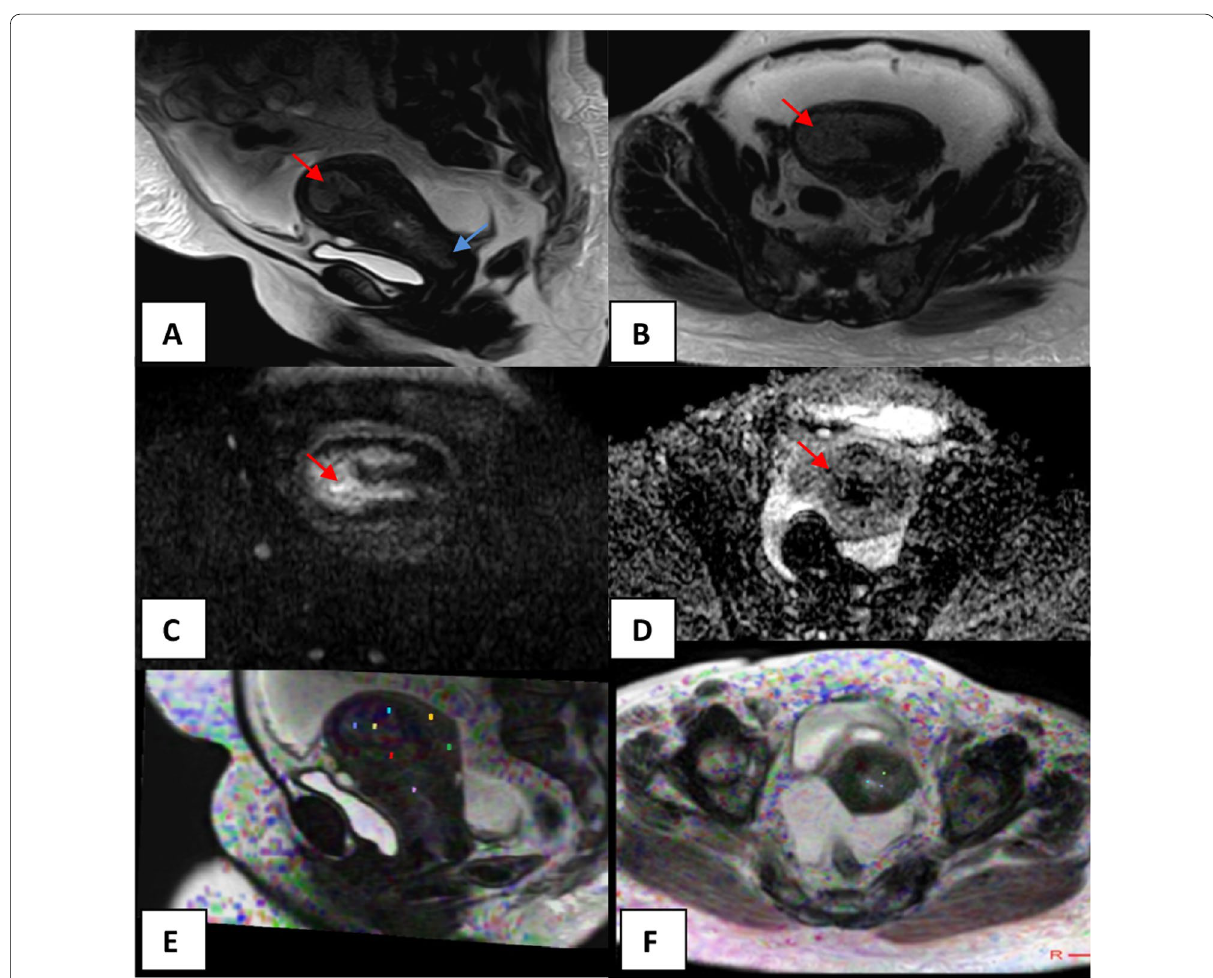
Fig. 6 A 54‑year‑old postmenopausal female presented by abnormal vaginal bleeding. A , B Sagittal and axial T2 WIs irregular endometrial soft‑tissue mass with ill‑defined margins displaying intermediate SI (red arrow). The mass distends and fills the endometrial cavity with myometrial thinning. The mass also extends to the cervix (blue arrow). C Axial DWI with b value of 1000 s/mm 2 high SI of the endometrial soft‑tissue mass (red arrow). D Axial DW-ADC map image low signal intensity of the endometrial soft‑tissue mass(red arrow). Mean DW‑ADC value of the mass 0.839 10 − 3 mm 2 /s. Mean DW‑ADC values at areas of intact and infiltrated myometrium = × Sagittal and axial DTI map images values of DT‑FA and DT‑MD in multiple ROI. Mean DT‑FA and DT‑MD values of the endometrial mass 0.711 10 − 3 mm 2 /s, respectively. Mean DT‑FA and DT‑MD values at areas of infiltrated myometrium × Mean DT‑FA and DT‑MD values at areas of intact myometrium endometrioid